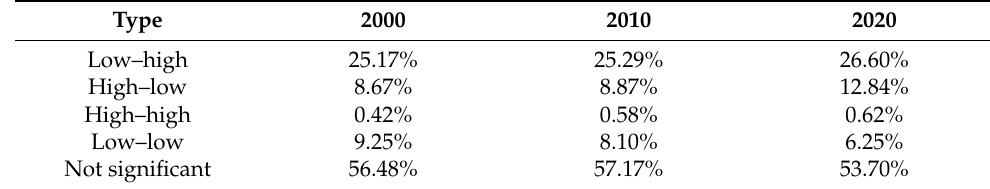
Table 7. Percentages of different types of LISA clusters, 2000–2020.